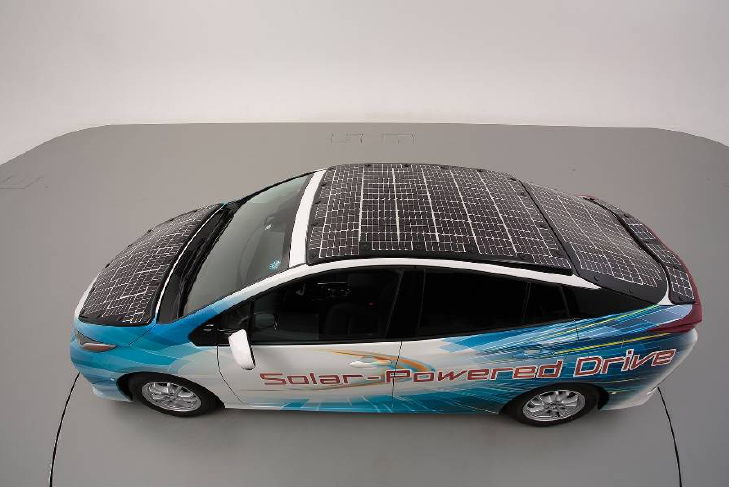
Figure 21. Picture of the Prius Plug-in Hybrid with solar cells